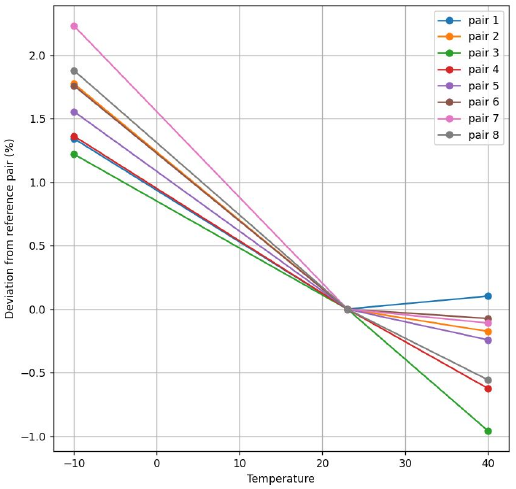
Figure 15. Flow deviation between 200 kHz pairs at 2000 L/h.